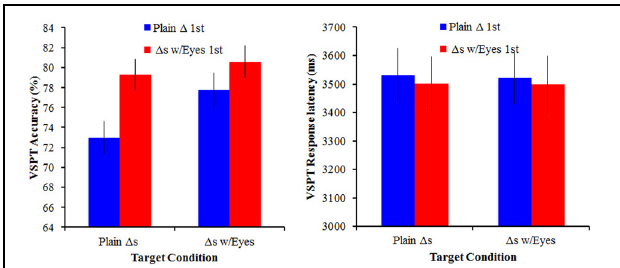
FIGURE 3 | VSPT performance (mean accuracy and response latency) as a function of the target conditions for Experiment 1. Error bars reflect ± 1 standard error of the